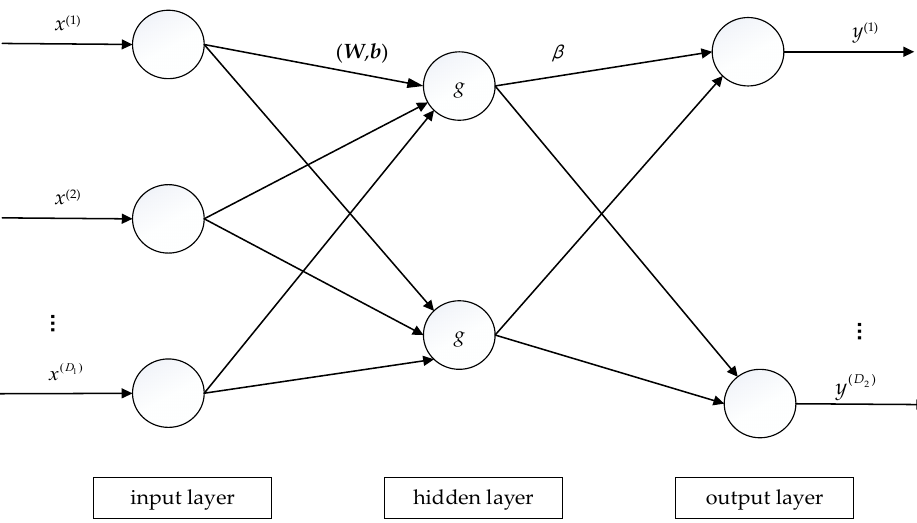
Figure 7. Diagram of an ELM neural network with a single hidden layer.